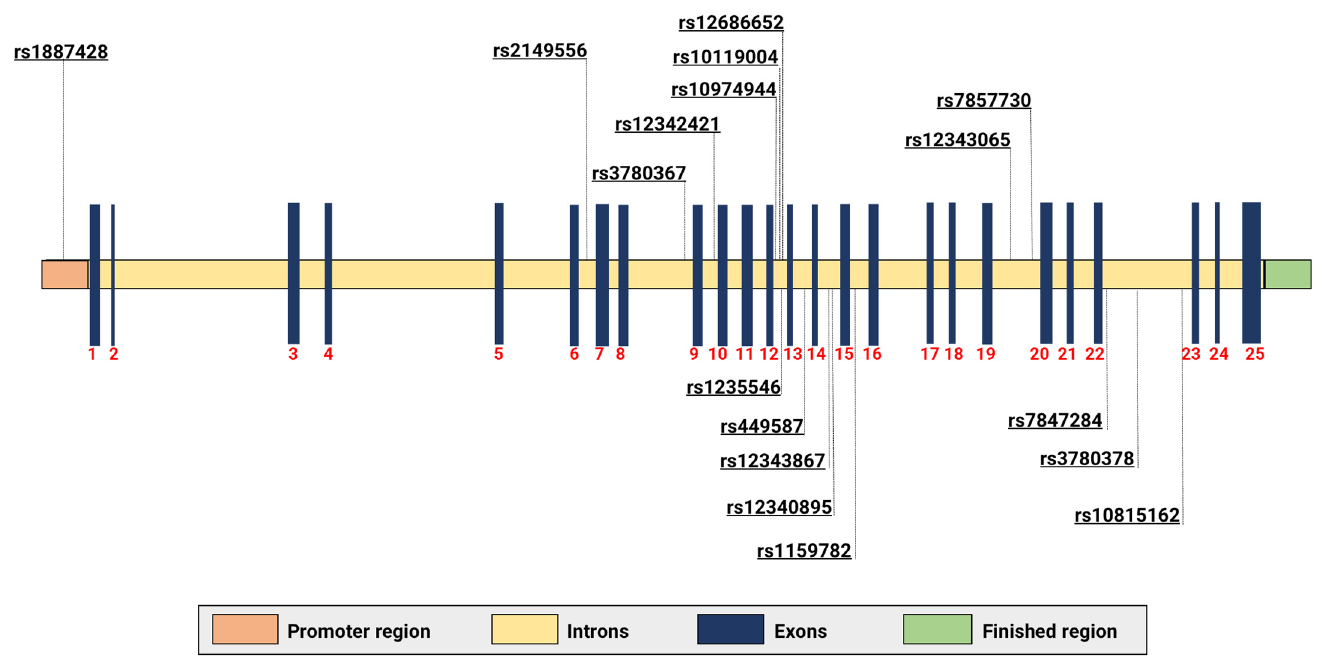
Figure 3. Location of variants identified in studies targeting the 46/1 haplotype. The mapping of variants along the gene was performed based on the reference sequence (NG_009904).